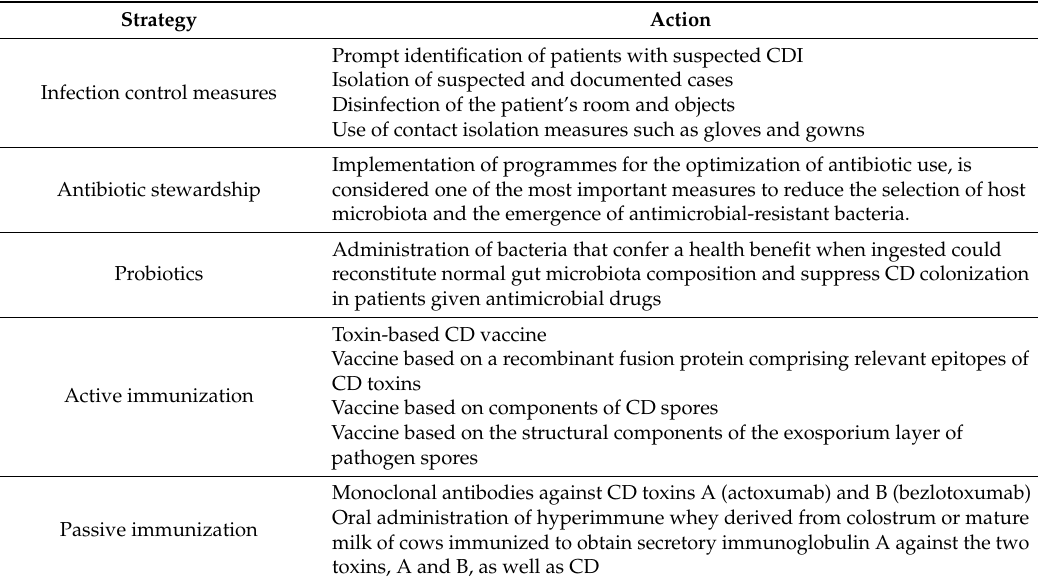
Table 1. Strategies for prevention against Clostridium di ffi cile infection